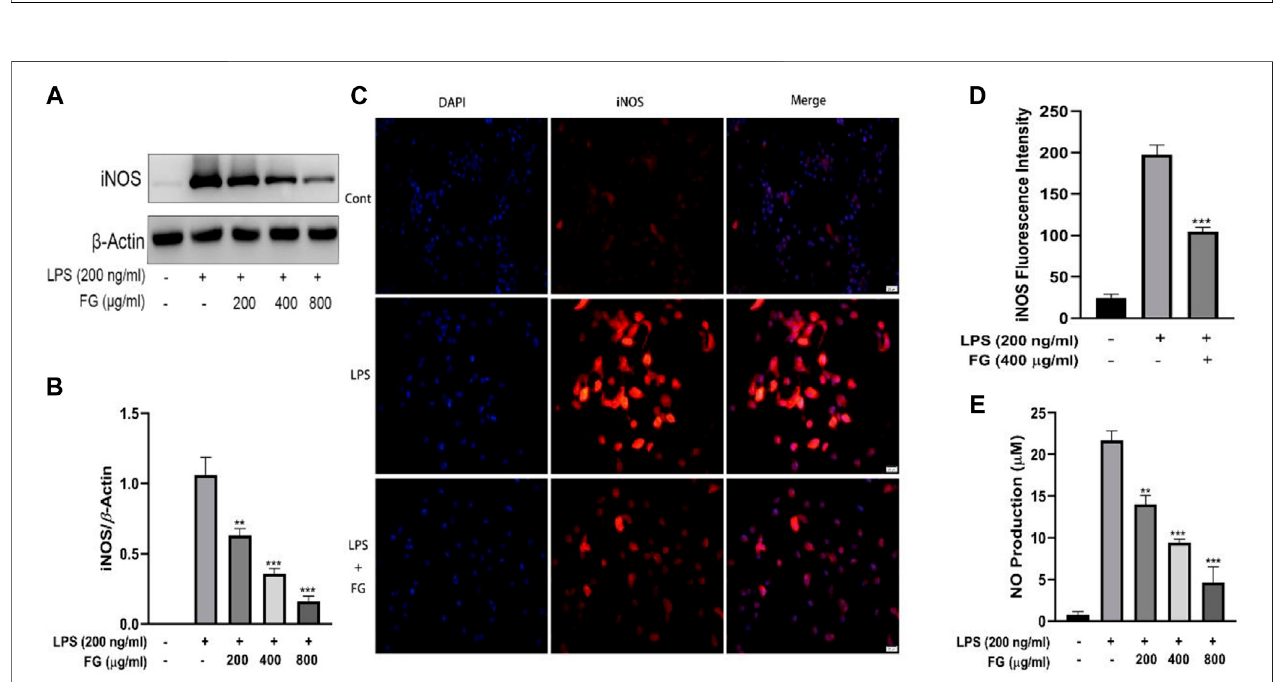
FIGURE 4 | Effect of FG on cellular ROS generation in LPS-induced BV2 microglia. BV2 cells were treated with FG extraction (200, 400, and 800 μ g/ml) in the presence of LPS (200 ng/ml) for 24 h. Cellular ROS level was evaluated using a DCFH-DA cellular ROS detection assay kit. Results are expressed as mean ± SEM of three independent experiments ( *** p <